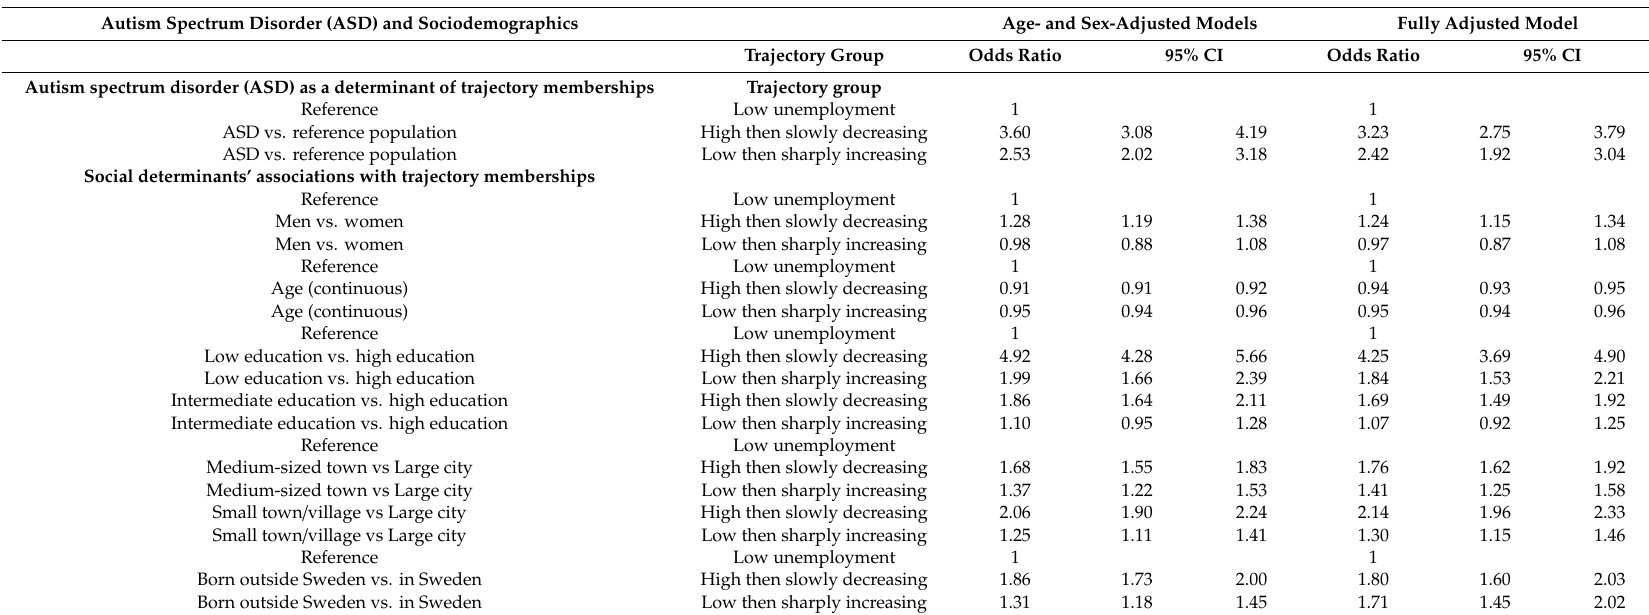
Born outside Sweden vs. in